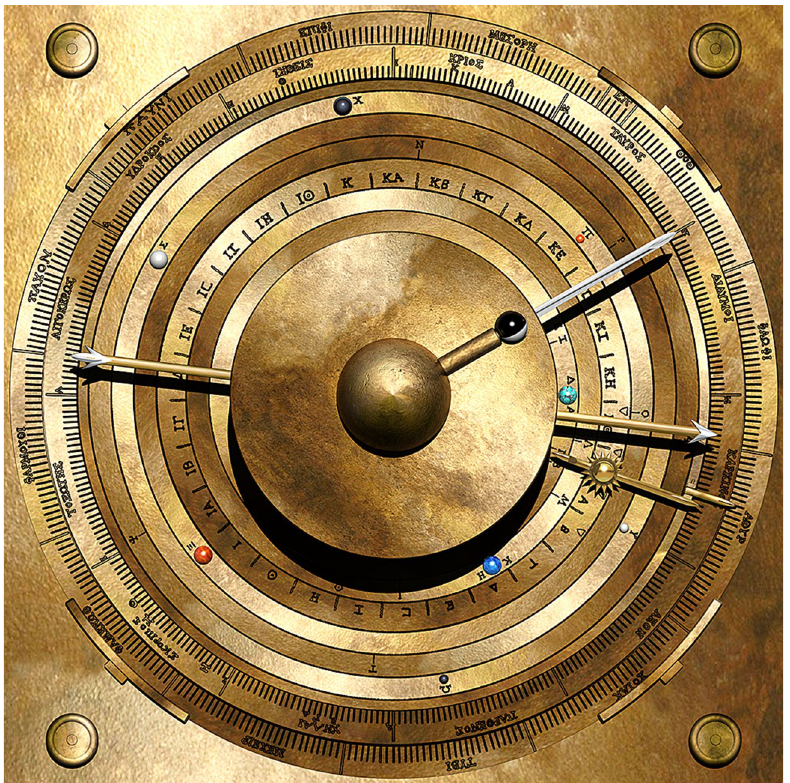
Figure 7. Computer model of the cosmos display. In the centre, the dome of the Earth, the phase of the Moon and its position in the Zodiac—then rings for Mercury , Venus , true Sun , Mars , Jupiter , Saturn and Date , with “little sphere” markers and smaller markers for oppositions. Scale marks and index letters for the synodic cycles of the planets are inscribed on the planet rings. Surrounding these, the Zodiac and the Egyptian Calendar 2 . The true Sun ring has a “little golden sphere” with “pointer” , as described in the BCI 9 . When the Moon and Sun pointers coincide, the Moon sphere shows black for New Moon; when the pointers are on opposite sides, the Moon sphere shows white for Full Moon 10 . The Head of the Dragon Hand shows the ascending lunar node ; the Tail the descending node . Small triangles on the true Sun ring, near the pointer, show wider and narrower eclipse limits. Eclipses are possible if the Dragon Hand is within these limits. When the Moon pointer is before the Head of the Dragon , the Moon is South of the node; after, it is North of the node—conversely for the descending node. A Date pointer is attached to a narrow date ring, showing the date in the Egyptian calendar 2